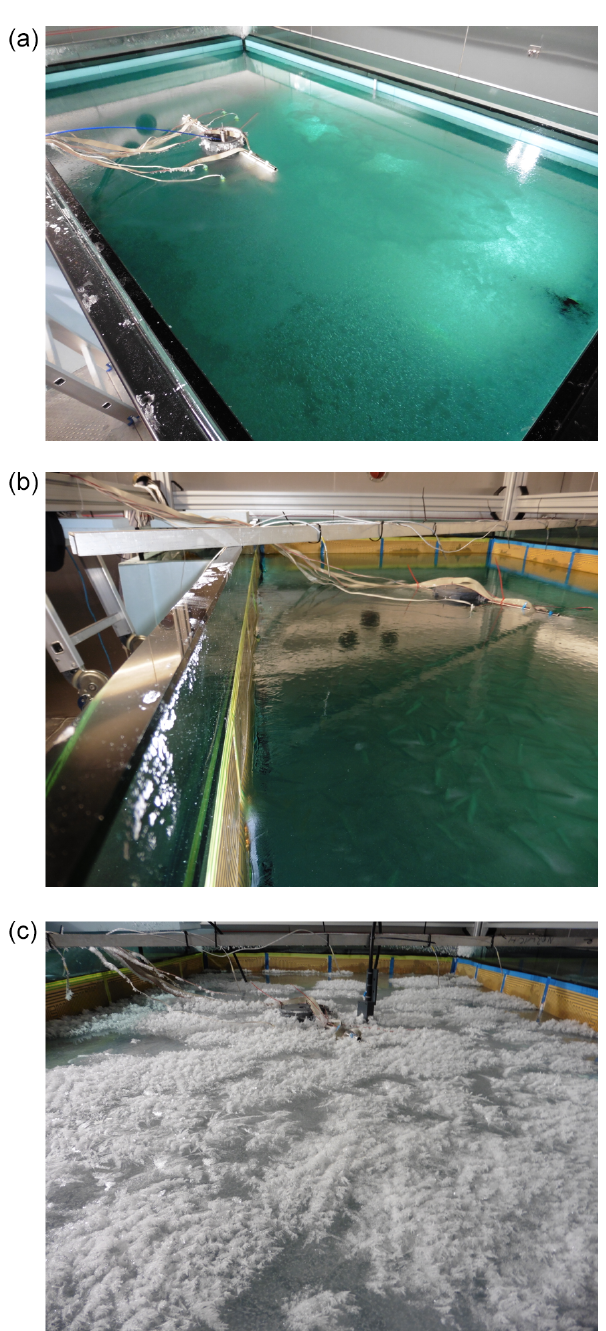
Figure 4. Grease ice (a) grown under pumping, nilas (b) grown in quiescent conditions, and a frost flower field (c) grown in the RvG- ASIC.